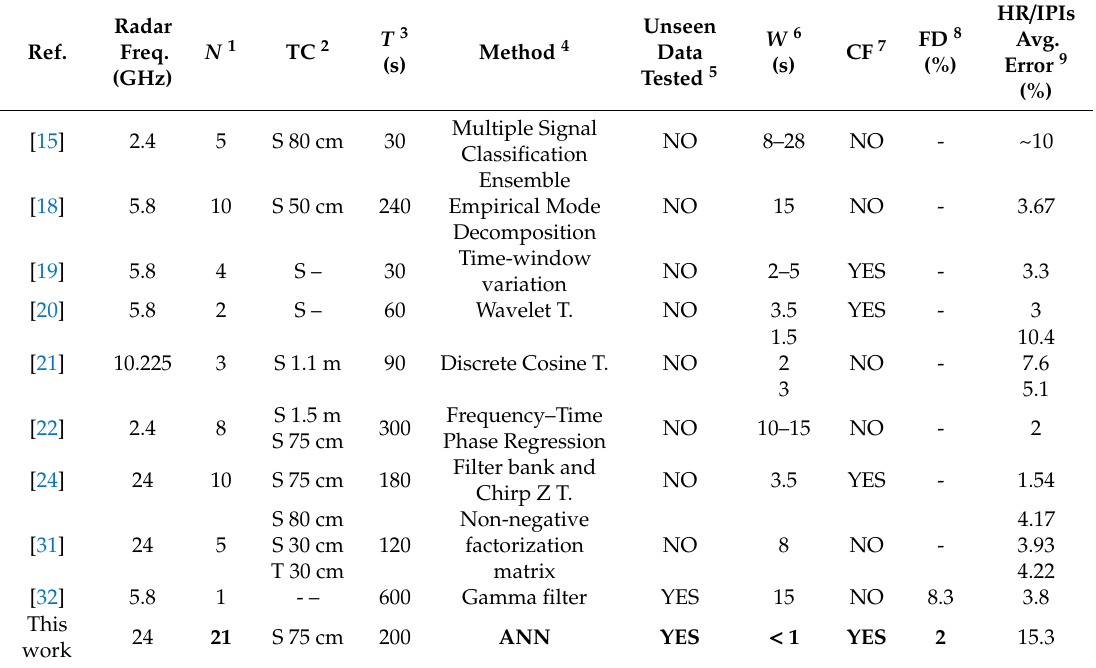
1 Number of subjects (N); 2 Test conditions (TC) during the measurement (S XX = Sitting at distance XX, T XX = Sitting and typing at distance XX); 3 Total measurement time ( T ) of normal breathing for each session; 4 Data processing approach; 5 Tested on data that were “unseen” in the training process; 6 Time window (W); 7 Calibration-free (CF) for I / Q imbalance, the o ff set compensation or usage of any demodulation techniques; 8 Failed detection (FD) of heartbeats; 9 Average Error of estimated heart rate or IPIs (HR / IPIs Avg.